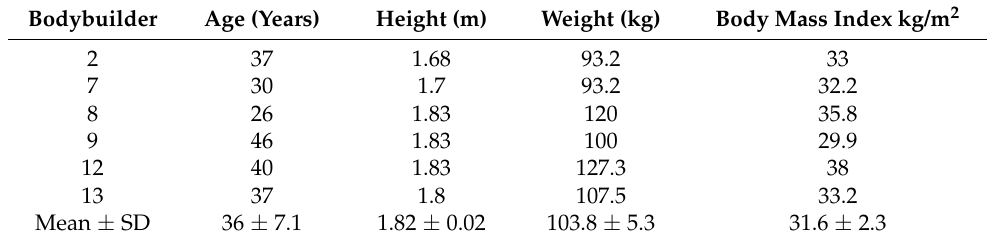
Table 3. Bodybuilder demographics.